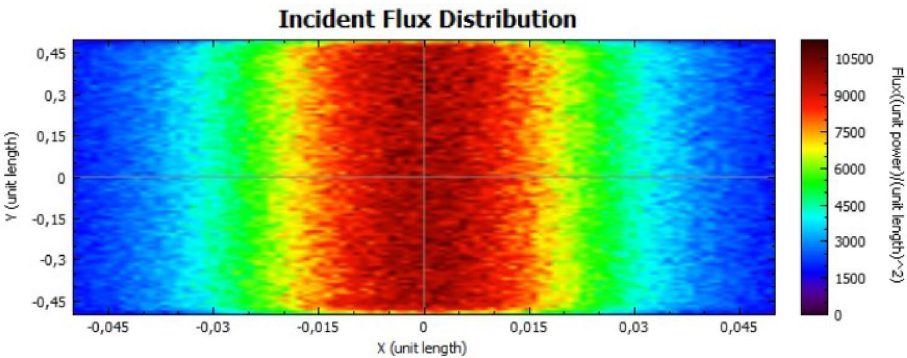
Figure 20. Incident Flux Distribution for an optical error of 0.030 (Parabolic Concentrator; 92% of reflectivity).